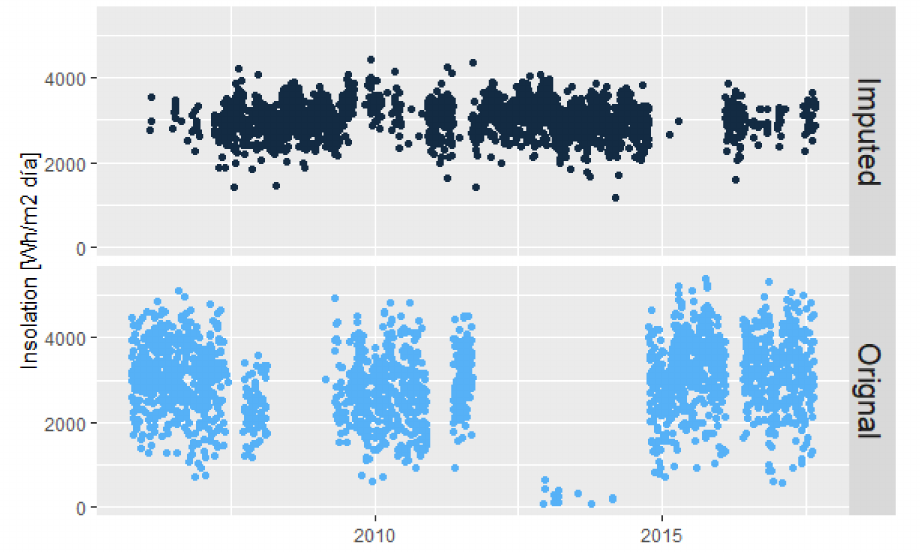
Figure 19. Guapi imputation.